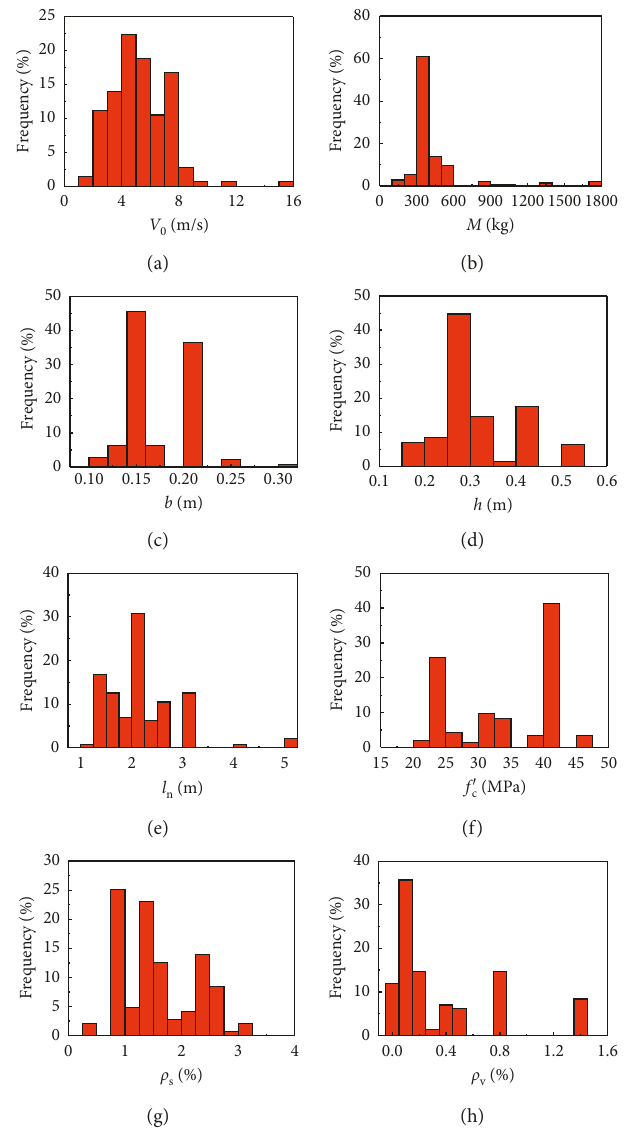
Figure 11: Distribution of the experimental parameters. (a) Impact velocity. (b) Impact mass. (c) Beams width. (d) Beams depth. (e) Net span. (f) Concrete strength. (g) Reinforcement ratio. (h) Stirrup